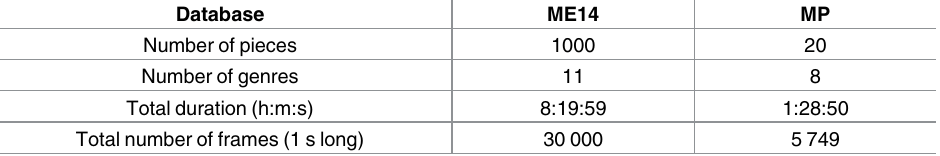
Table 3. Overview of the Mediaeval “Emotion in Music” task corpus ( ME14 ) and database derived from previous Music Psychology empirical studies ( MP